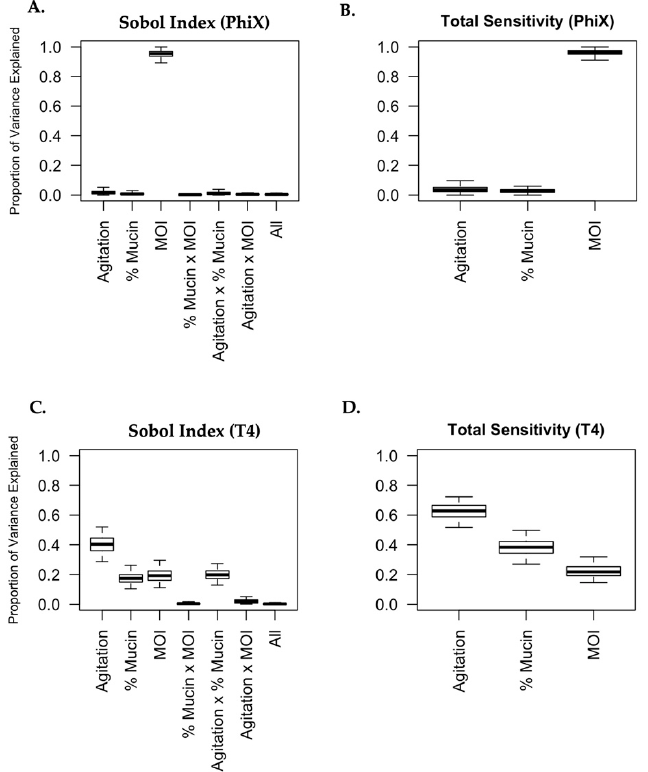
Figure 5. Phage predation is uniquely influenced by its surrounding micro-environment. Sobol variance-based sensitivity analyses were performed for PhiX ( A , B ) and T4 ( C , D ). The effect of each variable (agitation, mucin concentration, and MOI) and the possible interactions with other variables were broken into the proportions with which they contributed to the overall change in phage predation. The proportions were graphed as “Proportion of Variance” ( A , C ). The overall contribution of each variable to phage predation was also graphed as “Total Sensitivity” ( B , D ). Table 7. Estimated total sensitivity scores for each experimental factor.